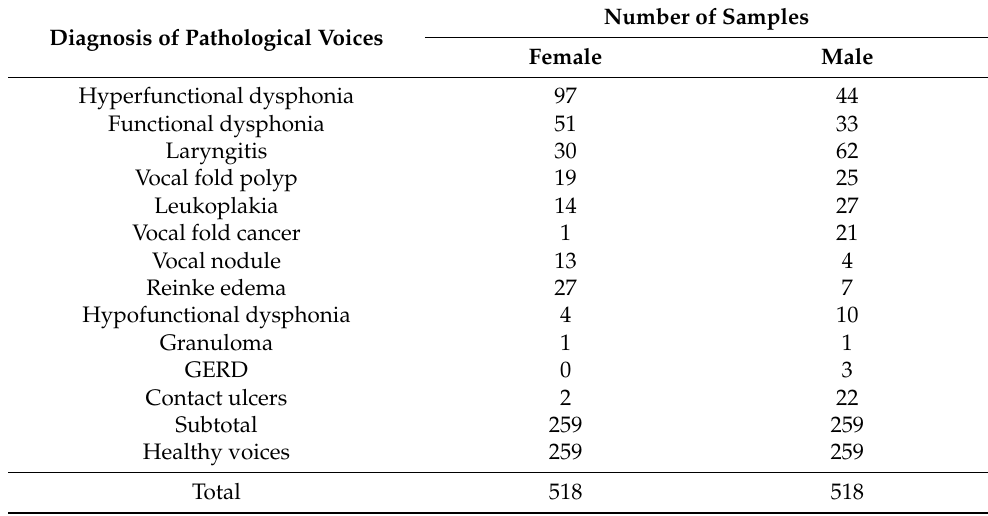
Table 1. Details of the voice samples used in the